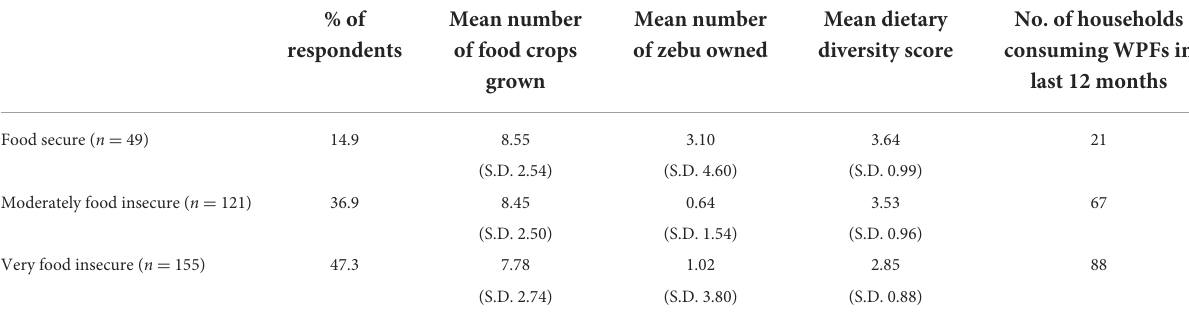
TABLE 4 Key results disaggregated by food (in)security